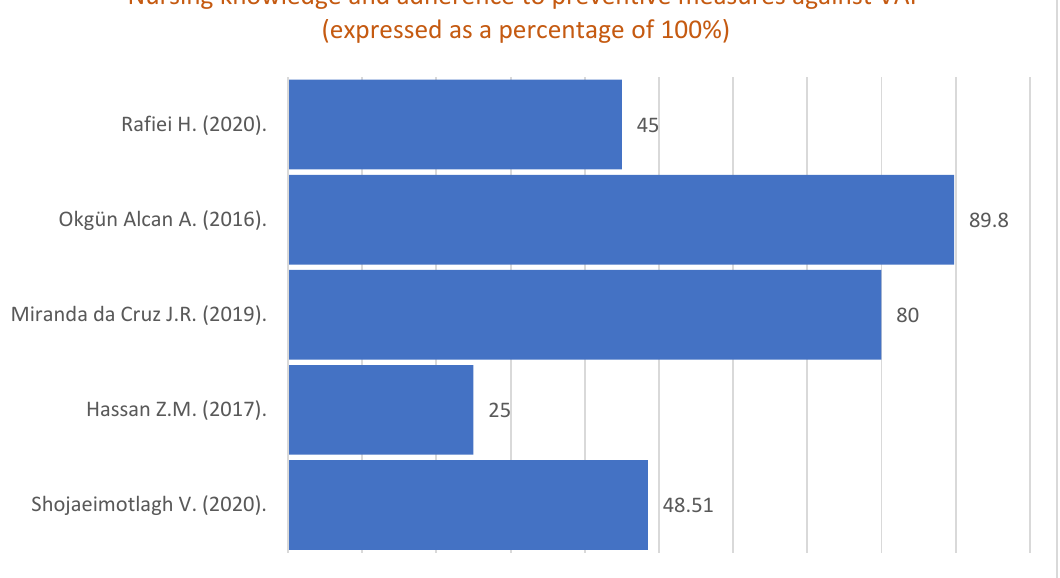
Figure 1. Results adherence and knowledge of nursing staff according to various studies [53,54,56–58].